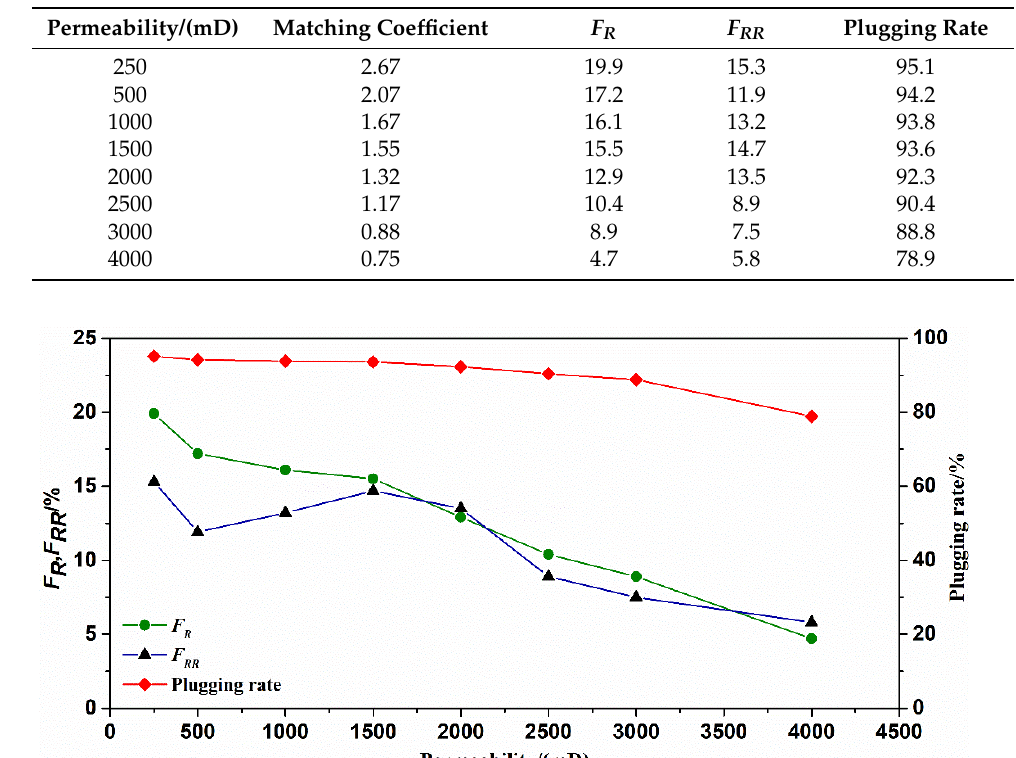
( a ) Experimental results corresponding to cores with different permeability